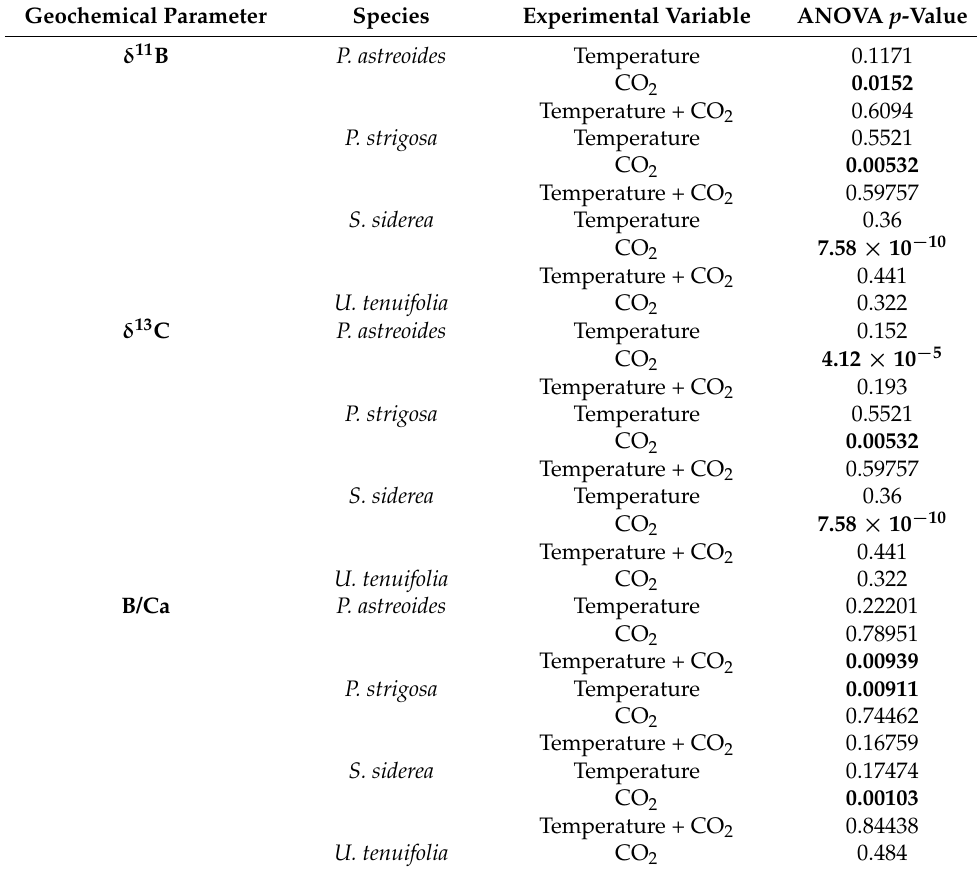
Table 2. 2-way ANOVA output testing the influence of temperature and p CO 2 on measured geo- chemical